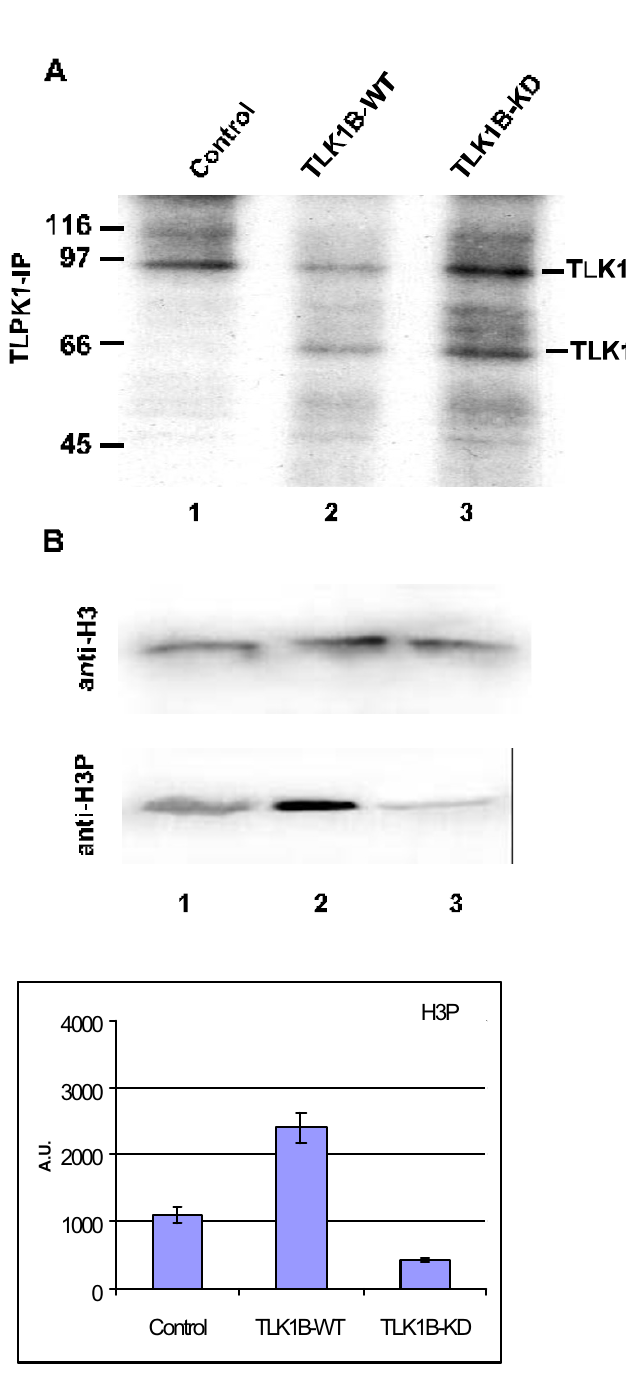
Figure 1 Overexpression of TLK1B-KD reduces the level of phosphorylated histone H3. a . Expression of wt and KD mutant TLK1B assessed by labeling the proteins with [ 35 S]methionine and immunoprecipitation [8]. b . Western blot of histone H3 and phos- phorylated H3 in the indicated cell lines, as explained in Methods. The bar-graph is the plot of three different experiments ana- lyzed by densitometry, and shown as the average for each cell line and standard